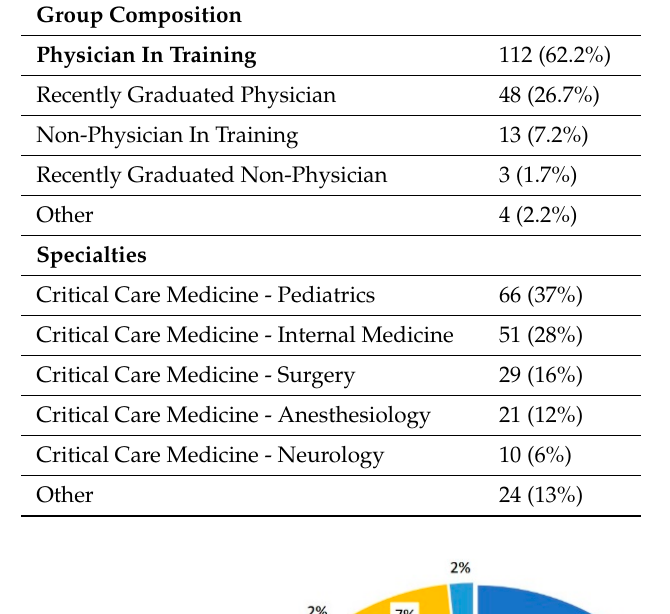
Table 1. Respondent demographics expressed as number (percentage).